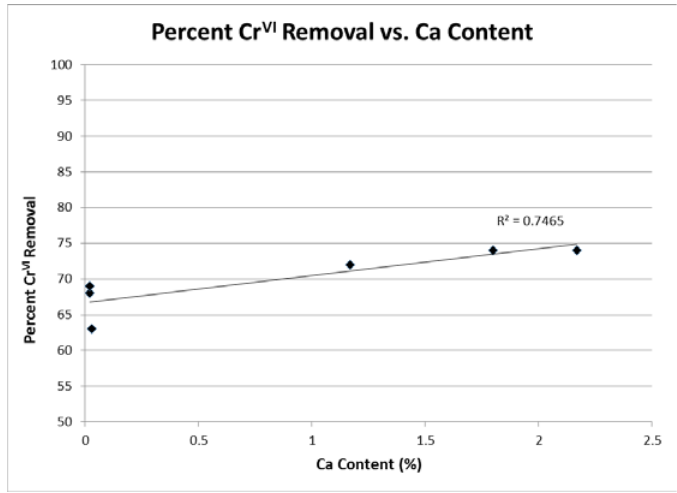
Figure 2. Percent Cr VI removal versus calcium content. Figure 3. Percent Cr VI removal versus sulphur content.